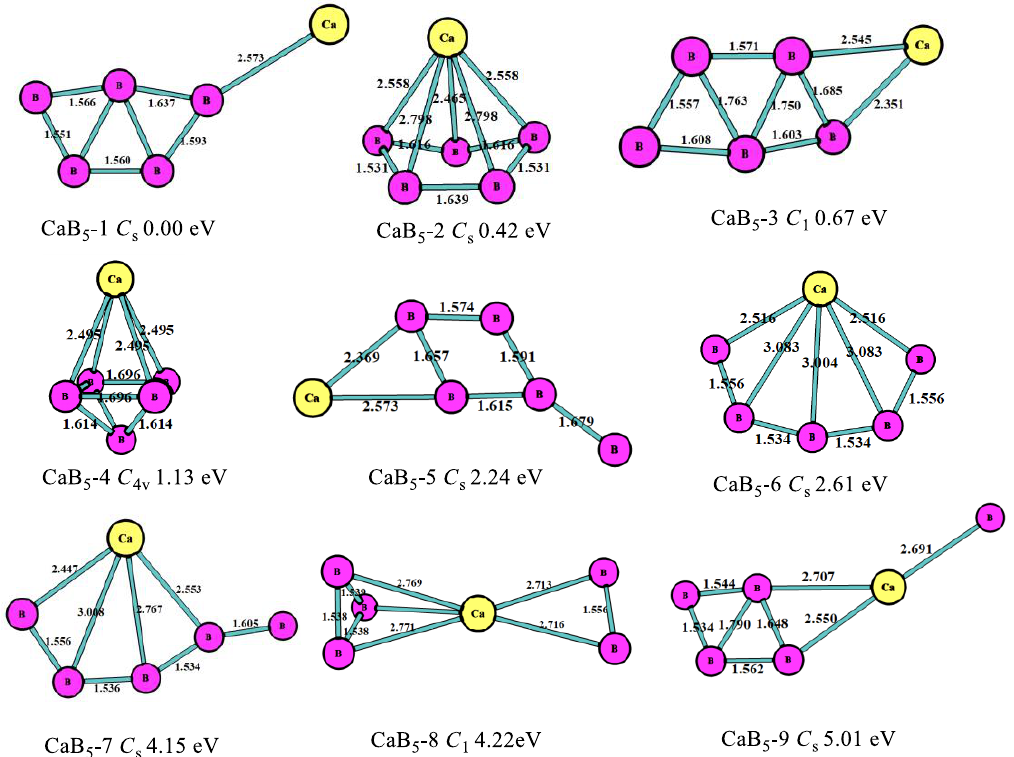
Figure 3. The geometry structures of the CaB 5 clusters obtained at MP2/6-311+G(d)//B3LYP/6-311+G(d). The bond length unit is Å.